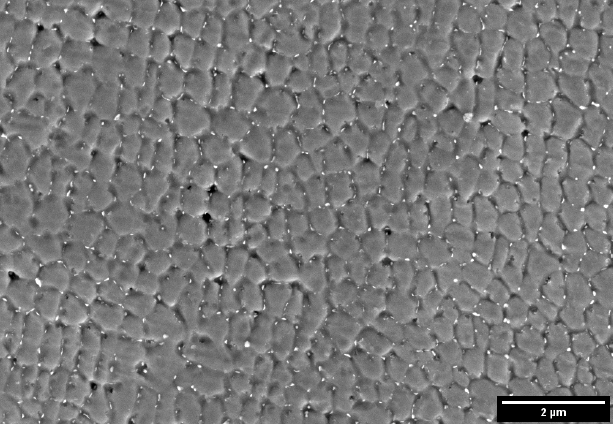
Figure 14. Microstructural detail of L-PBF René 80 in the as-built state observed with secondary electrons in the SEM.